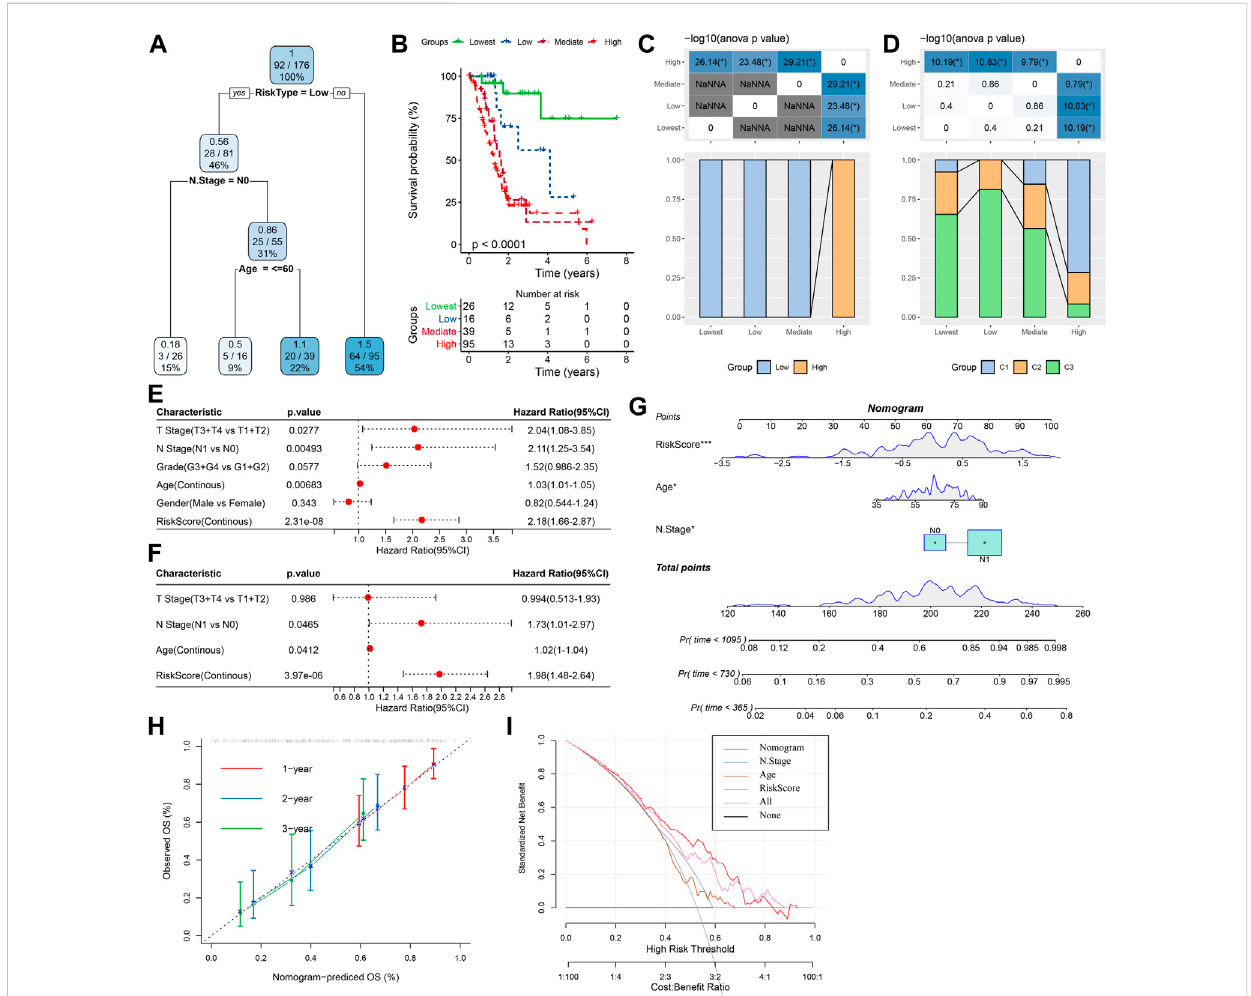
FIGURE 9 The nomogram of prognostic risk models with clinicopathological features. (A) To optimize risk strati fi cation, patients with full-scale annotations including TNM Stage, age, gender, and RiskScore were enrolled for developing a survival decision tree; (B) Risk subgroups showed signi fi cant overall survival differences; (C, D) Comparative analysis between different subgroups; (E, F) RiskScore and clinicopathological (E, F) Univariate and multifactorial Cox analysis on clinicopathological features and RiskScore; (G) The nomogram model; (H) Calibration curves for 1, 3, and 5 years (s) of the nomogram; (H:Decision curve for the columnar graph; (I) The most powerful capacity of the nomogram for survival prediction when compared with other clinicopathological features. * p < 0.05; ** p < 0.01; *** p < 0.001; and **** p <